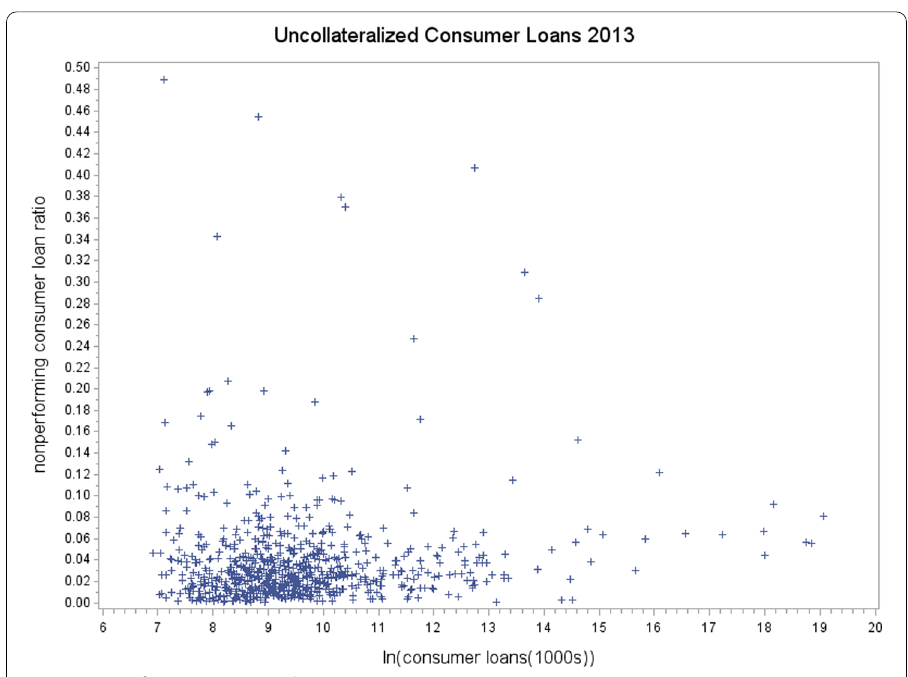
Fig. 4 Nonperforming consumer loan ratio: